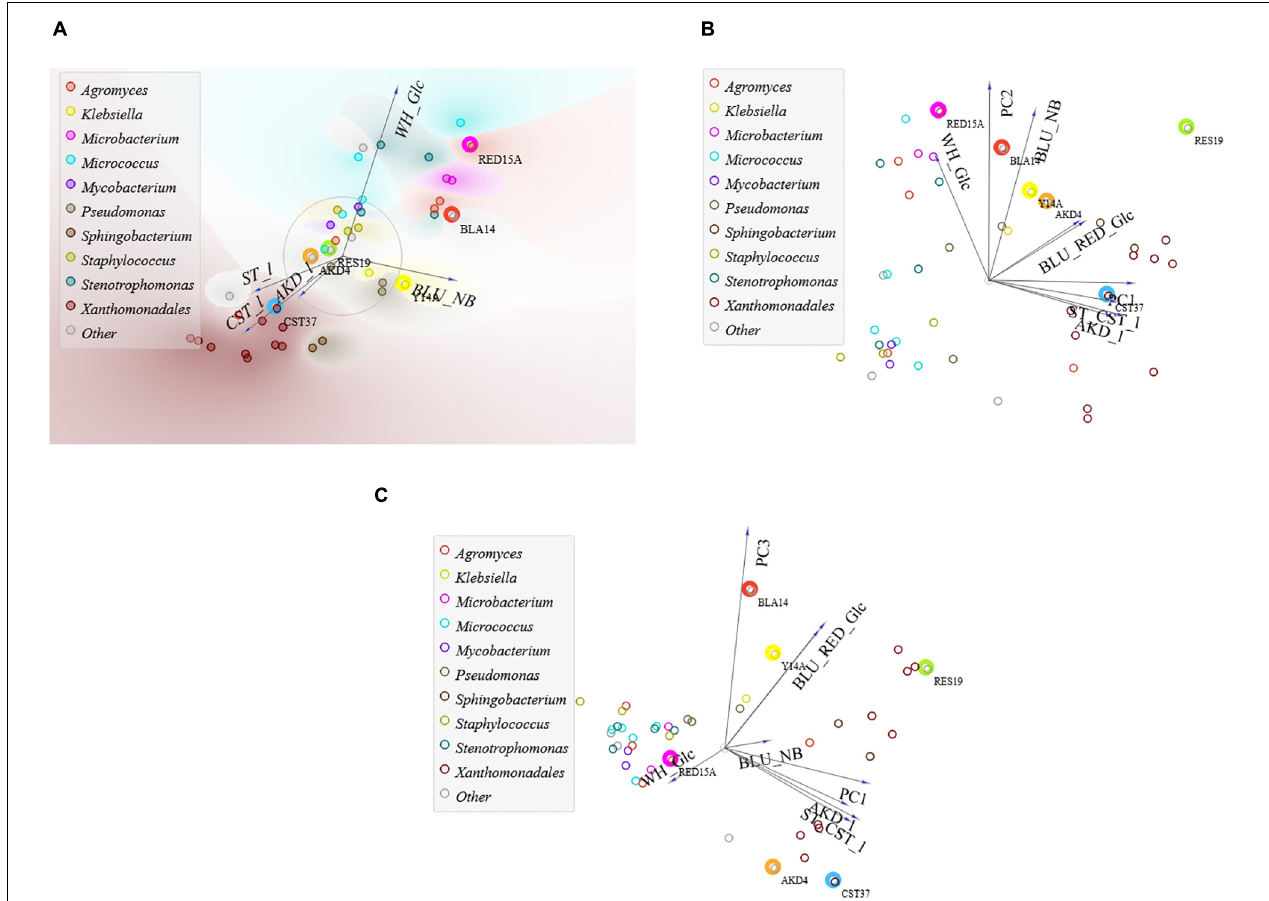
FIGURE 4 | FreeViz and PCA of tests for the repertoire of carbon sources of 44 isolates in liquid media with genera for clusters. (A) FreeViz projection and (B) PC1PC2 with 77% and (C) PC1PC3 with 62% explained variances. RED15A (circled in pink), BLA14 (red), Y14A (yellow), RES19 (green), AKD4 (brown), and CST37